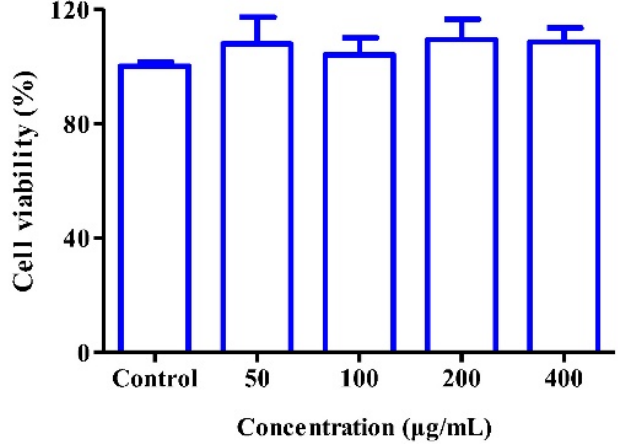
Figure 6. Toxicity of blank PL against HUVECs at the indicated concentrations for 24 h ( n = 5).